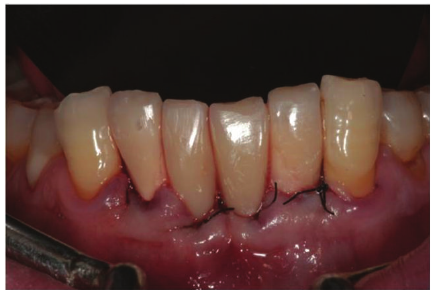
Figure 6: Immediate temporary